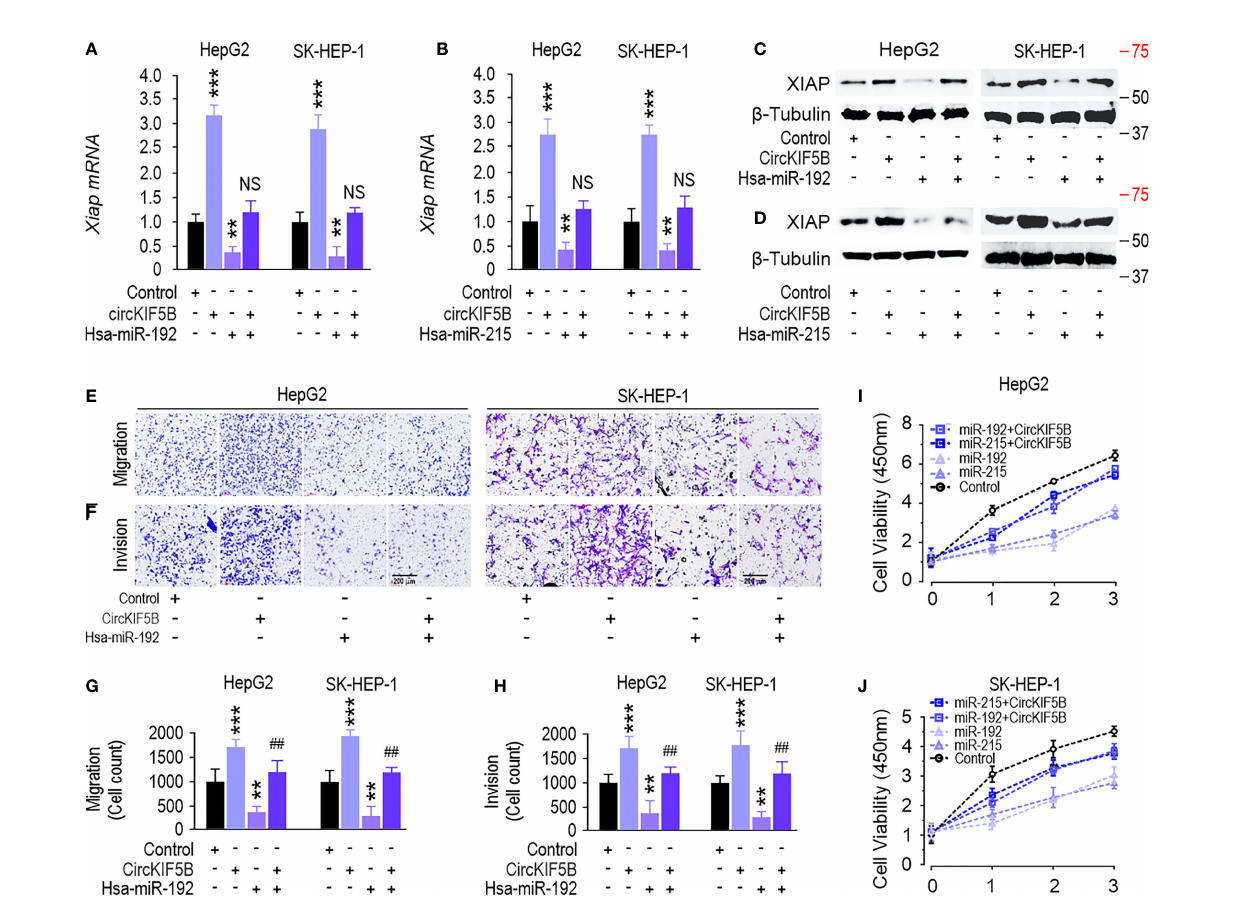
FIGURE 6 | CircKIF5B regulates XIAP expression and inhibits liver cancer progression via targeting the miR-192 family. (A, B) qRT-PCR showed that miR-192 family attenuated circKIF5B caused XIAP mRNA expression increase. (C, D) Western blot showed that miR-192 family attenuated circKIF5B caused XIAP protein expression increase. (E, F) Migration and invasion ability of circKIF5B and miR-192s in HepG2 and SK-HEP-1 cells. (G, H) Colorimetric measurement of panels (E, F) . (I, J) The viability of circKIF5B and miR-192s evaluated by CCK-8 assay in HepG2 and SK-HEP-1 cells. *p < 0.05, **p < 0.01, ***P < 0.005; ## p < 0.01 compared with miR-192